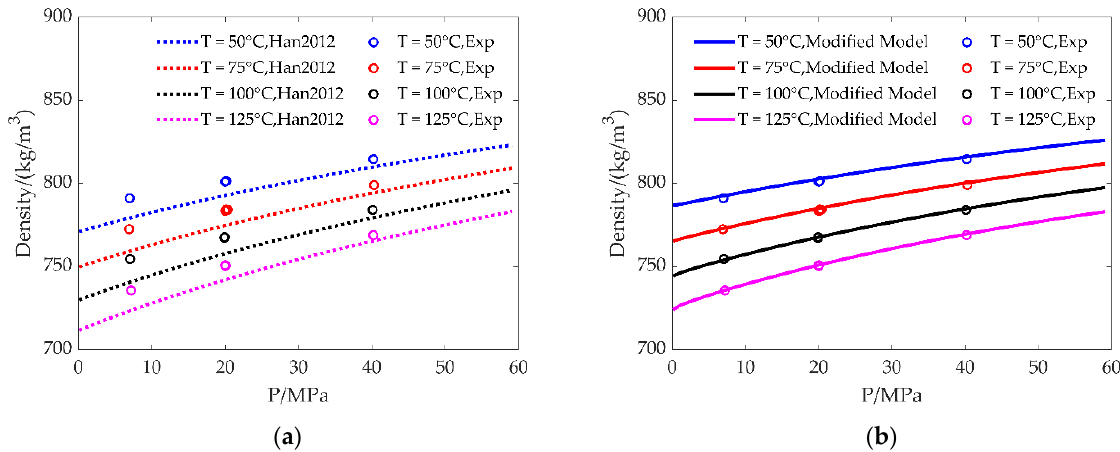
Figure 6. Comparison of model results with experimental data (Calabrese [32]), X CO2 = 0.2 (mole fractions): ( a ) Han’s model; ( b ) the modified model.